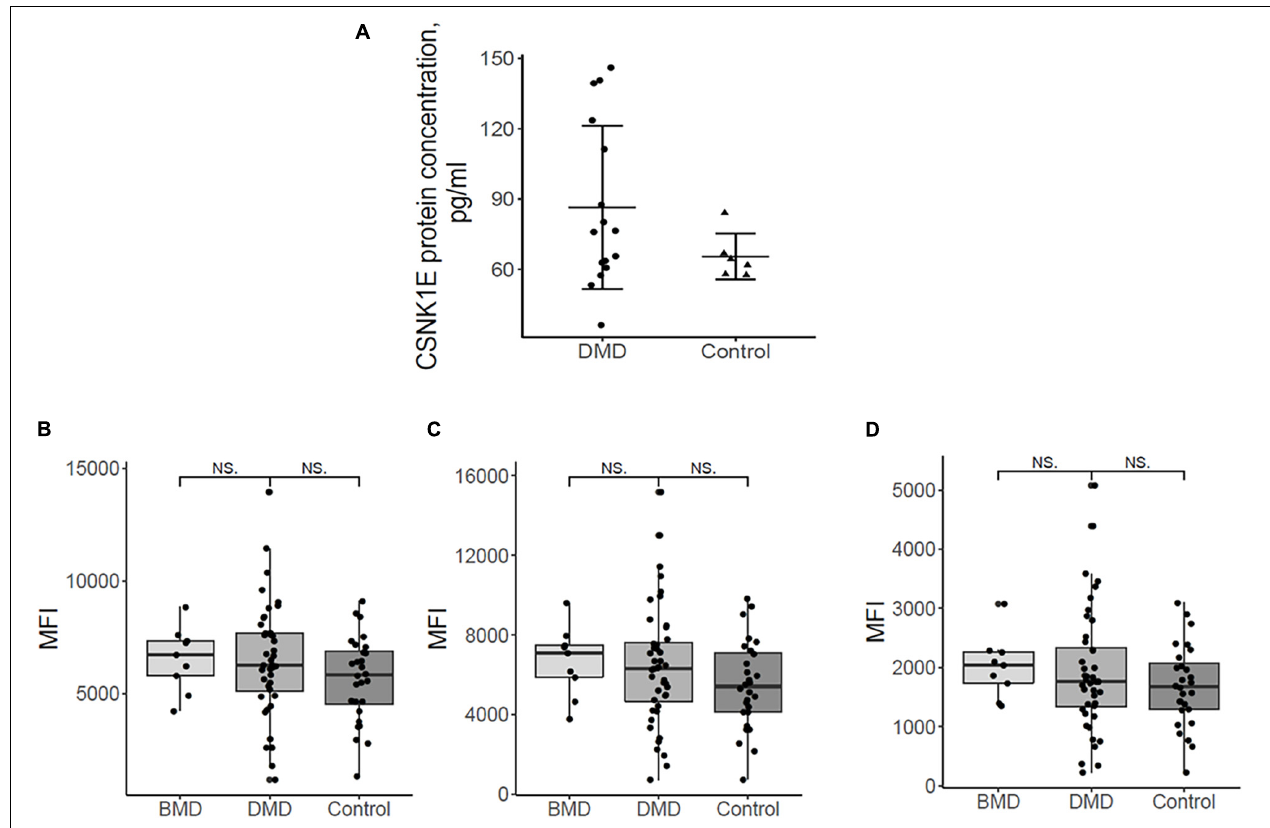
FIGURE 3 | (A) Plasma protein dosing of selected upregulated DMD genes. Csnk1 ε protein plasma levels in DMD patients ( n = 16) are slightly elevated with respect to controls ( n = 6). (B) the mean fluorescence intensity (MFI) for sirtuin 1, HPA006295 antibody, and (C) MFI for sirtuin 1, HPA007016 antibody. (D) MFI